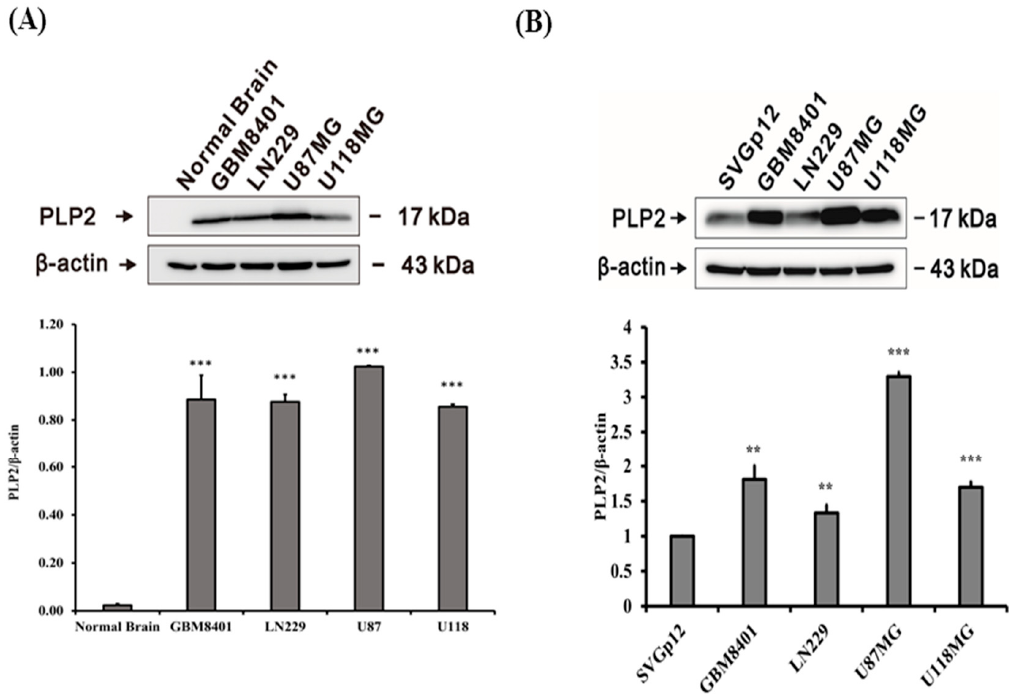
Figure 1. Expression analysis of proteolipid protein 2 (PLP2) in glioma cell lines and normal brain tissues. ( A ) Analysis of PLP2 protein expression in GBM8401, LN229, U87, and U118MG glioma cell lines and normal brain tissue protein lysates. ( B ) Analysis of PLP2 protein expression in GBM8401, LN229, U87, and U118MG glioma and the human fetal glial cell line SVG p12 glial cell lines. The densitometric analysis revealed a higher percentage of peak of PLP2 (17 kDA) in all glioma